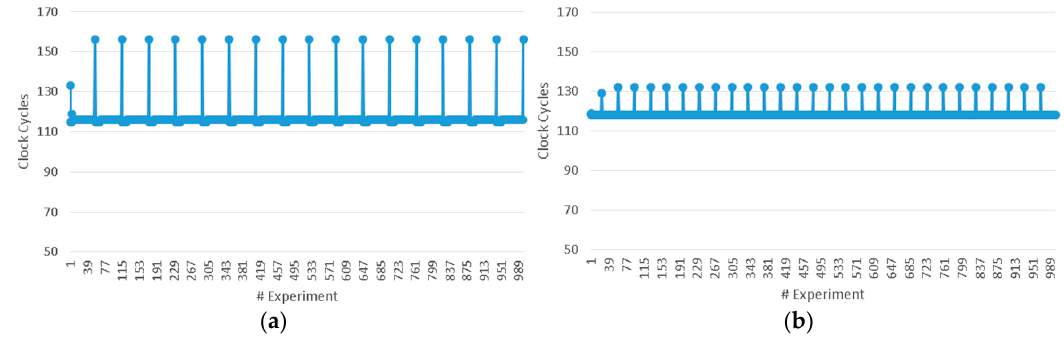
Figure 5. Latency measurements. ( a ) Addresses differ by 64–1024 bytes; ( b ) Addresses differ by 8–64 bytes